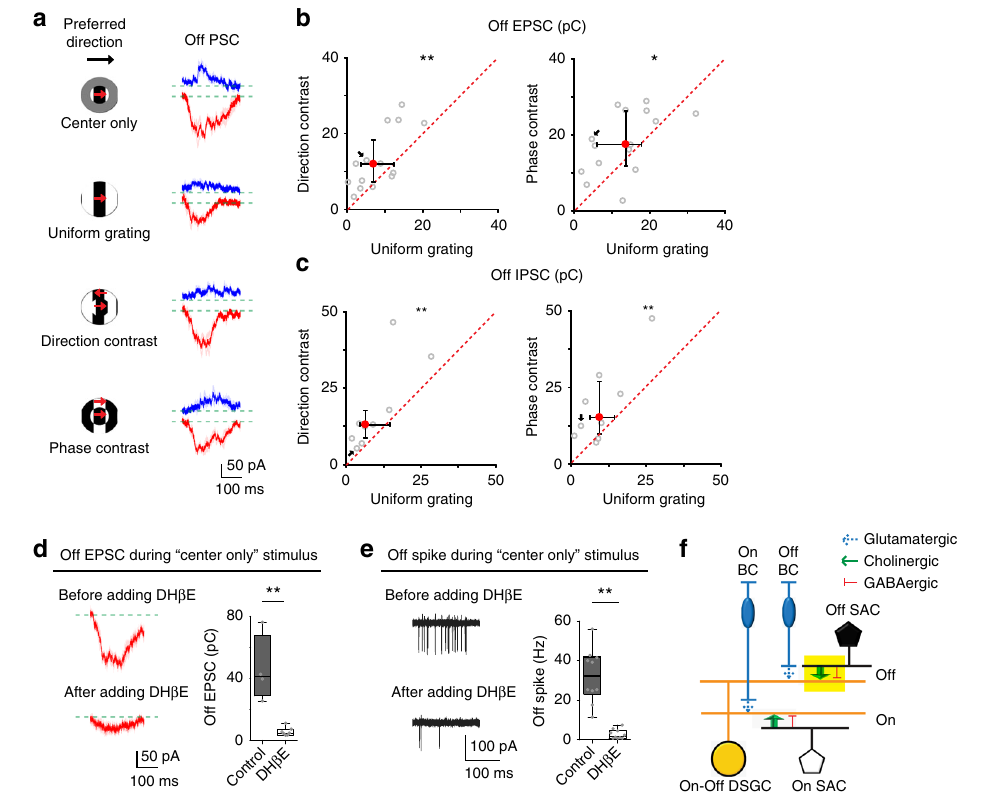
Fig. 2 Contextually sensitive cholinergic excitation underlying the differential modulation of pDSGC Off response. a Whole-cell recording traces of Off IPSCs (blue) and Off EPSCs (red) from a pDSGC in a control mouse. PSC traces represent trial average (darker traces) and SEM (lighter traces) for this and subsequent fi gures. b Scatter plots compare Off EPSC charge transfer between uniform grating and compound gratings. Direction-contrast vs uniform grating: n = 15 cells from 11 mice, ** p = 0.0043; Phase-contrast vs uniform grating: n = 15 cells from 9 mice, * p = 0.035 (Wilcoxon signed-rank test). c Same as b , but for Off IPSC charge transfer. Direction-contrast vs uniform grating: n = 9 cells from 5 mice, ** p = 0.0039; Phase-contrast vs uniform grating: n = 10 cells from 6 mice, ** p = 0.0098. d Left: Example Off EPSC traces of a pDSGC during center only grating before and after adding DH β E. Right: Summary graph of pDSGC Off excitatory charge transfer in control (Ames ’ solution, n = 4 cells from 2 mice) or in the presence of DH β E ( n = 7